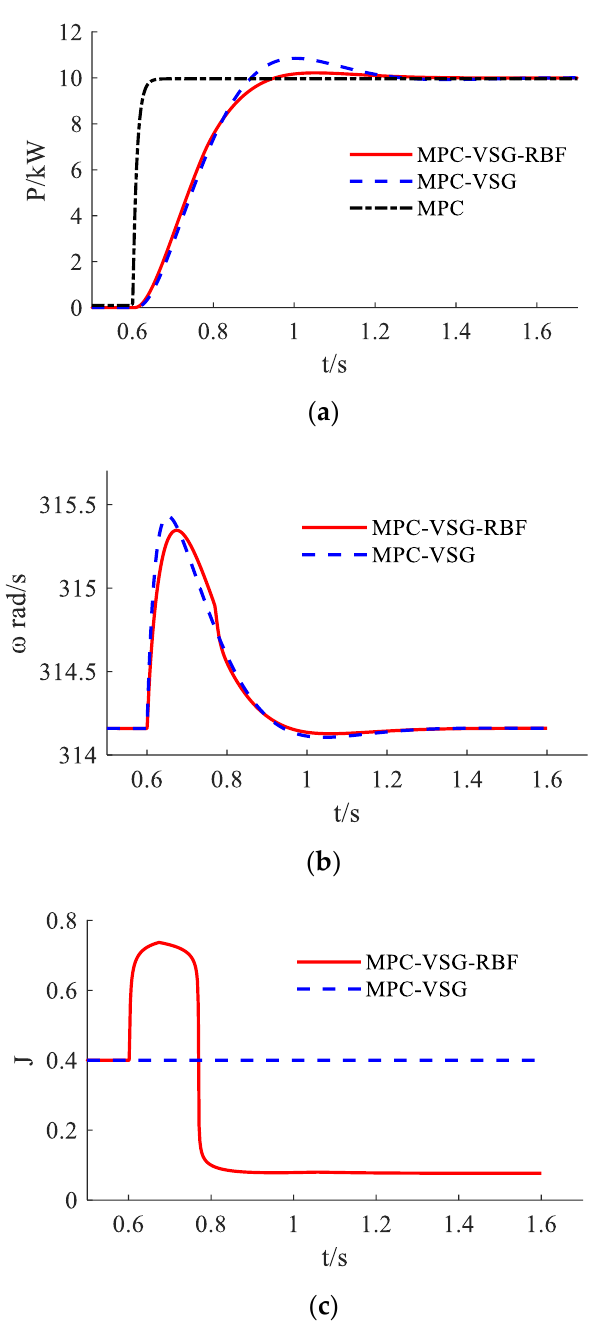
Figure 5. Under imbalance of power supply and demand: ( a ) active power waveform comparison; ( b ) angular velocity waveform correlation.; ( c ) change in moment of inertia J.